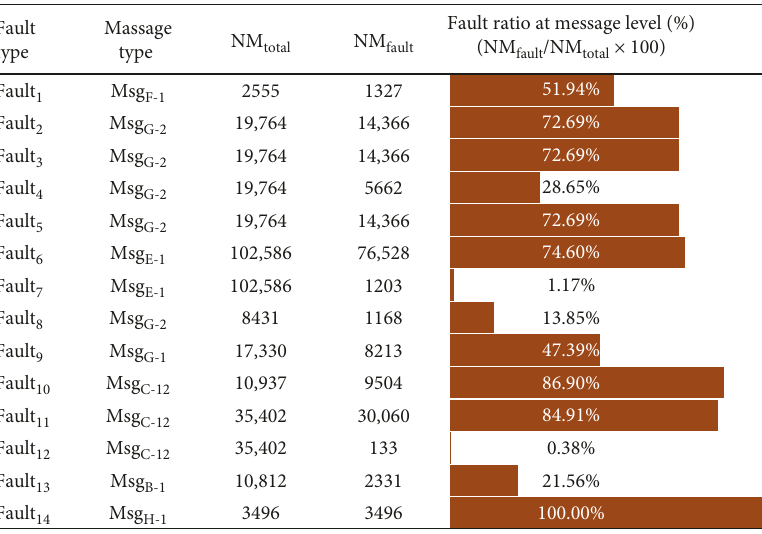
Figure 11: Number of faulted messages and fault ratios at message level.